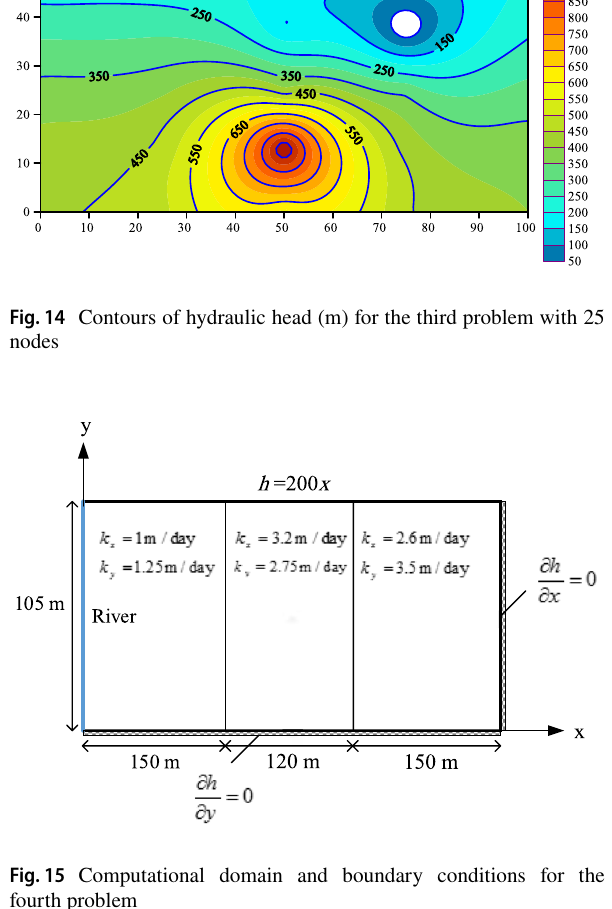
Fig. 15 Computational domain and boundary conditions for the fourth problem Fig. 16 Meshed domain with a 4900 elements, b 18 elements for the fourth